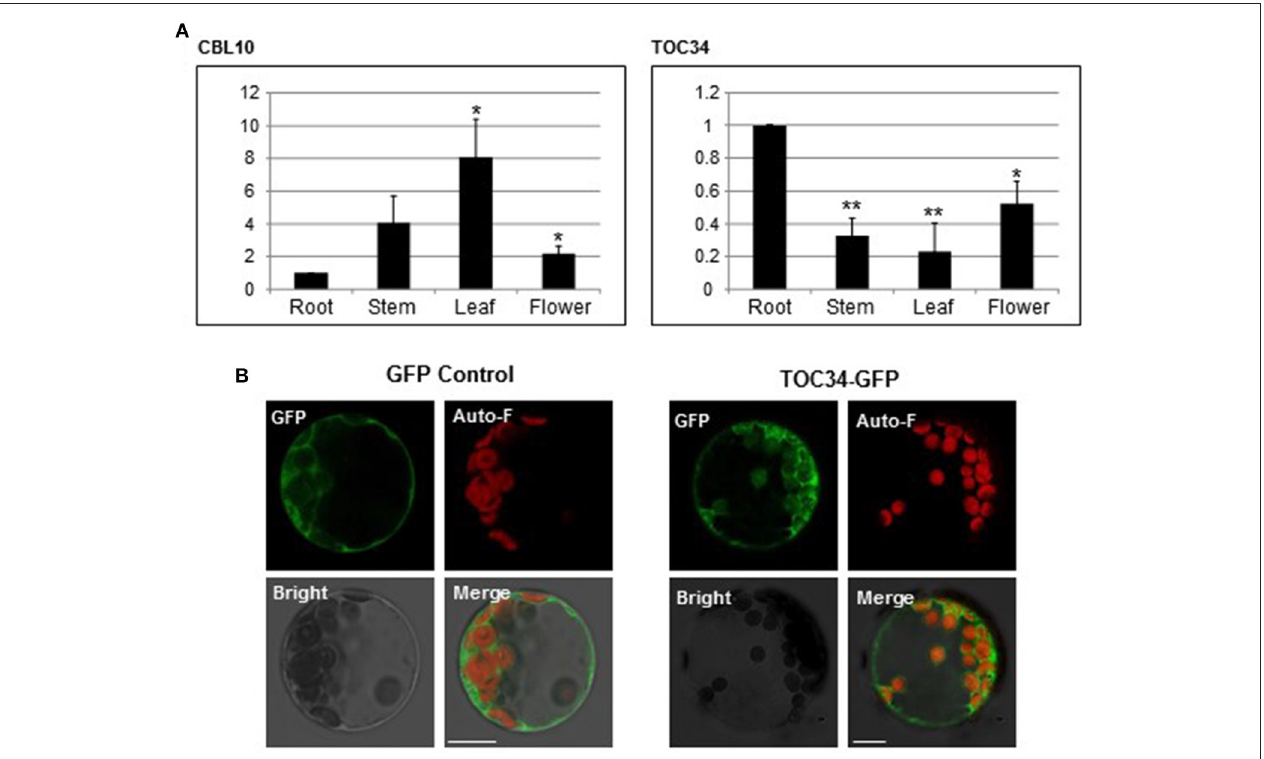
FIGURE 6 | Expression patterns of TOC34 and subcellular localization of TOC34. (A) Expression patterns of TOC34 and CBL10 using qRT-PCR analysis. The expression levels of TOC34 and CBL10 in roots were set to 1.0 to show relative abundance differences. Actin2 gene was employed as an internal control. Error bars denote standard deviation (SD) of three technical replicates. Significance was calculated using the Student’s t -test: * P < 0.05, ** P < 0.01. (B) Localization pattern of TOC34. Arabidopsis protoplasts were transfected with 35S::GFP (left two columns) or 35S::TOC3-GFP (right two columns), and GFP fluorescence was examined. GFP, Auto-F, Bright, and Merge indicate GFP fluorescence signal, auto-fluorescence signal, bright field image, and merged image, respectively. Scale bars 15 µ m (left two columns) and 20 µ m (right two